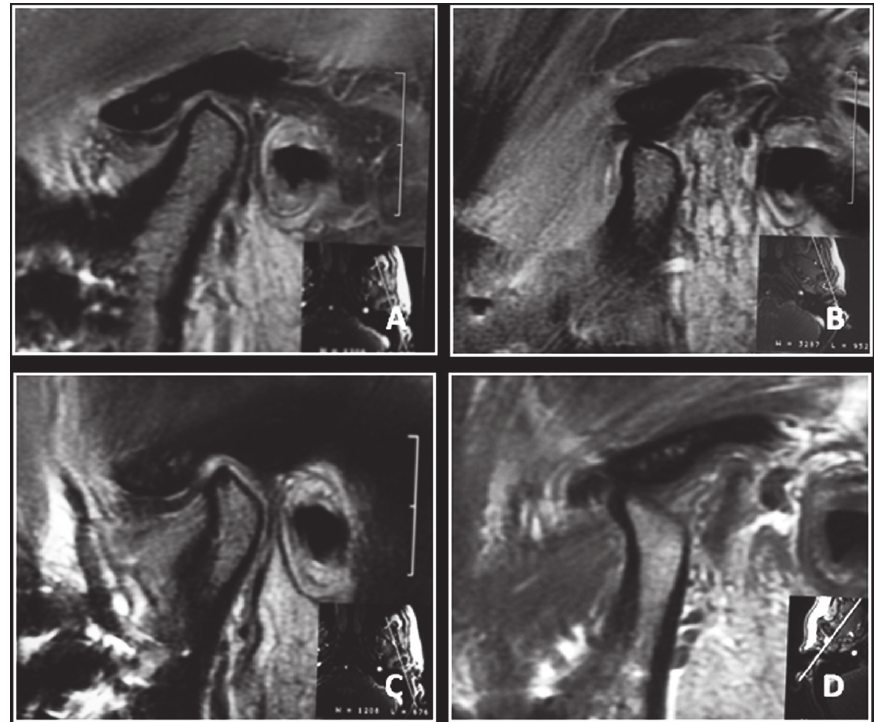
Figure 3- Presurgical magnetic resonance of temporomandibular joint showing disc displacement with reduction (A and B), and 10 years after mandibular surgical advancement (C and D) showing the maintenance of the disc status and the onset of condylar